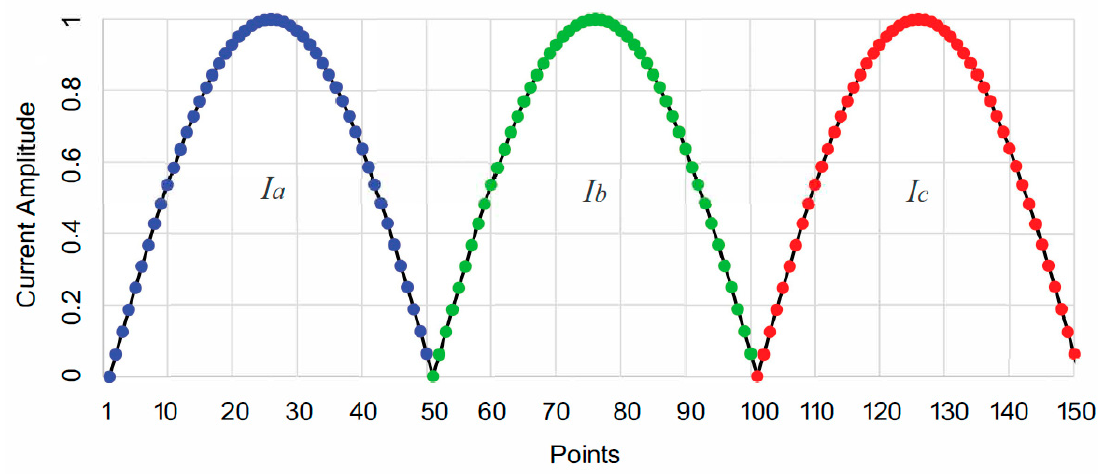
Figure 2. Input data modeling: current discretization and normalization.